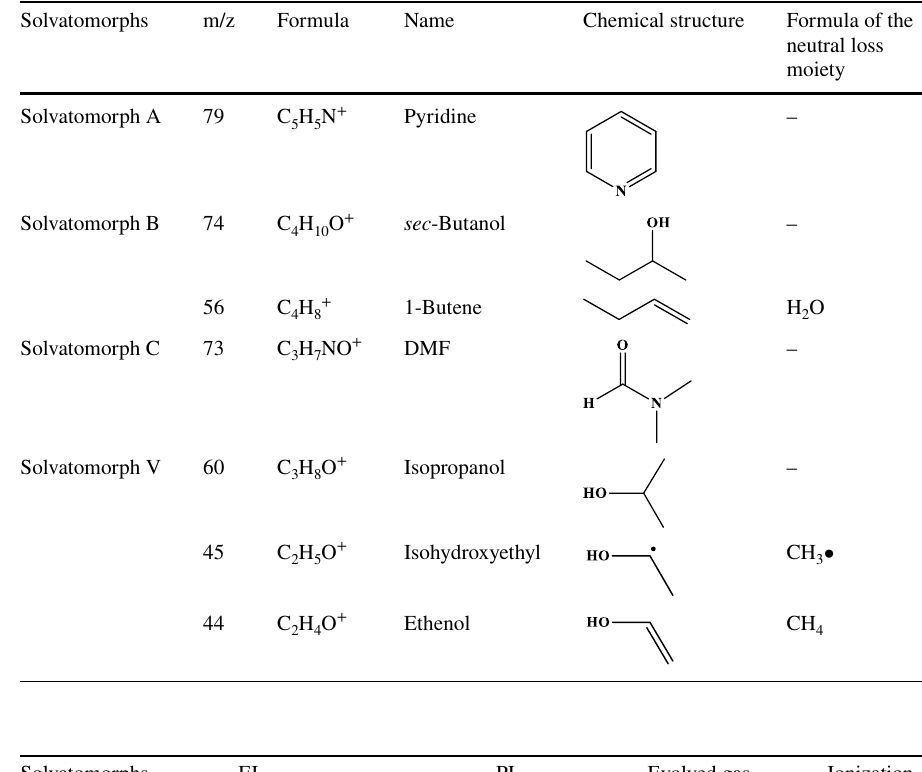
Table 2 Evolved gases analysis results of four solvatomorphs by EI and PI method